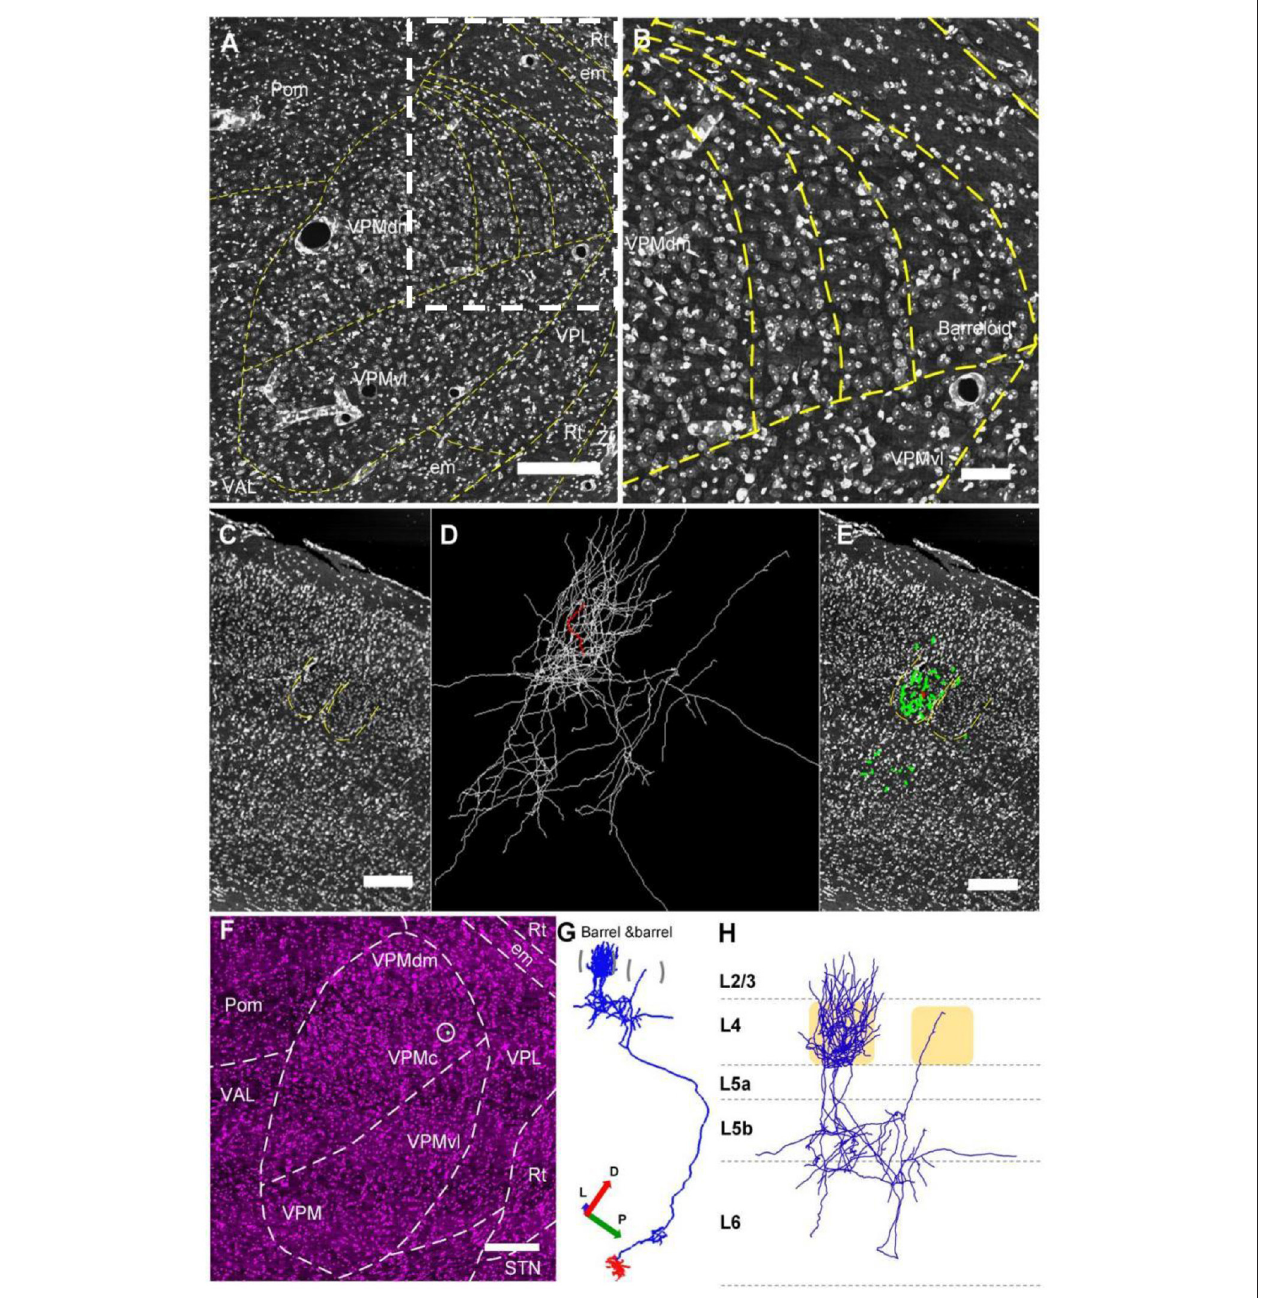
FIGURE 2 | The whole reconstructed 3D morphology of an individual VPM neuron. (A,B) Constructing the border between VPMdm and VPMvl region. (A) Manually outlined contours of the borders of barreloids and the borders between the VPMdm and VPMvl compartments. (B) The amplification from the white dashed box in (A) . (C–E) The thalamocortical organization of an individual VPM neuron. This VPM neuron projects to the barrel column in cortex. Green and white lines in (D) and (E) : the same reconstructed morphology in cortex of VPM neuron. Red lines: axons in the barrel. Regions indicated by yellow in (C) and (E) : barrels and septa. (F–H) Whole reconstructed 3D morphology of this VPM neuron. (F) The VPM neuron in the VPMc region. White dot in white circle: soma. (G) The 3D morphology of VPMc neuron projecting to barrel column and Rt. Blue lines: axons. Red lines: dendrites. (H) Axon distribution in the barrel column. Scale bars, 250 µ m (A–H) . D, Dorsal; P, Posterior; L,